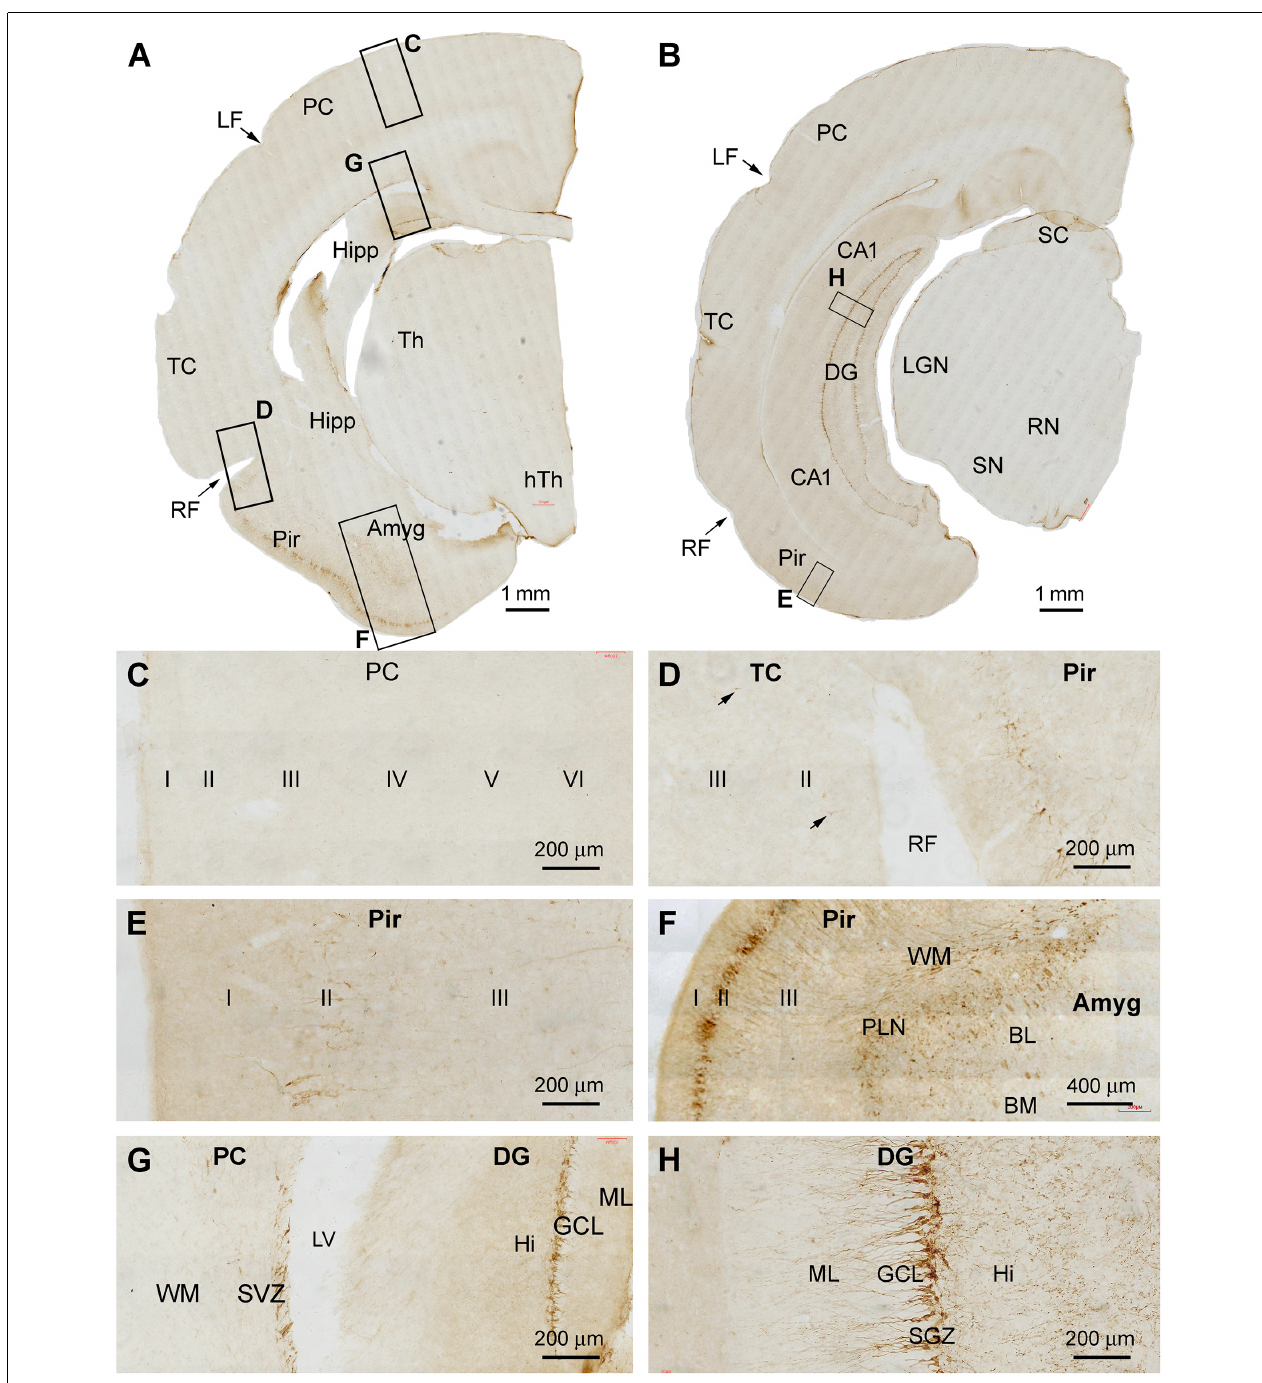
FIGURE 2 | DCX+ cellular profiles in the middle part of the forebrain in a 2 months-old Chinese tree shrew. Panels (A,B) are low magnification views of immunolabeled hemispherical sections at the levels passing the rostral end of the hippocampus (Hipp) and the lateral geniculate nucleus (LGN), respectively, with framed areas enlarged as panels (C–H) . No labeled cells are seen in the parietal neocortex (PC) and the majority of the temporal neocortex (TC) (C,D) , while a few cells could be detected in the temporal cortex surrounding the rhinal fissure (RF) ( D , pointed by arrows). In contrast, a large number of labeled cells occurs in the piriform cortex (Pir) over layer II (D–F) . Abundant labeling is present in the amygdala (Amyg) near its border to the white matter of the adjoining piriform and temporal cortices (F) . DCX+ neurons and processes are distinctly present at the subventricular zone (SVZ) next to the lateral ventricle (LV) and in the subgranular zone of the dentate gyrus (DG) (G,H) . Additional abbreviations: Th, thalamus; LF, lateral fissure; CA1, Ammons’ horn CA1 sector; SC, superior colliculus; RN, red nucleus; SN, substantia nigra; WM, white matter; PLN, paralaminar nucleus; ML, molecular layer; GCL, granule cell layer; Hi, hilus. I, II ... VI: cortical layers. Scale bars are as